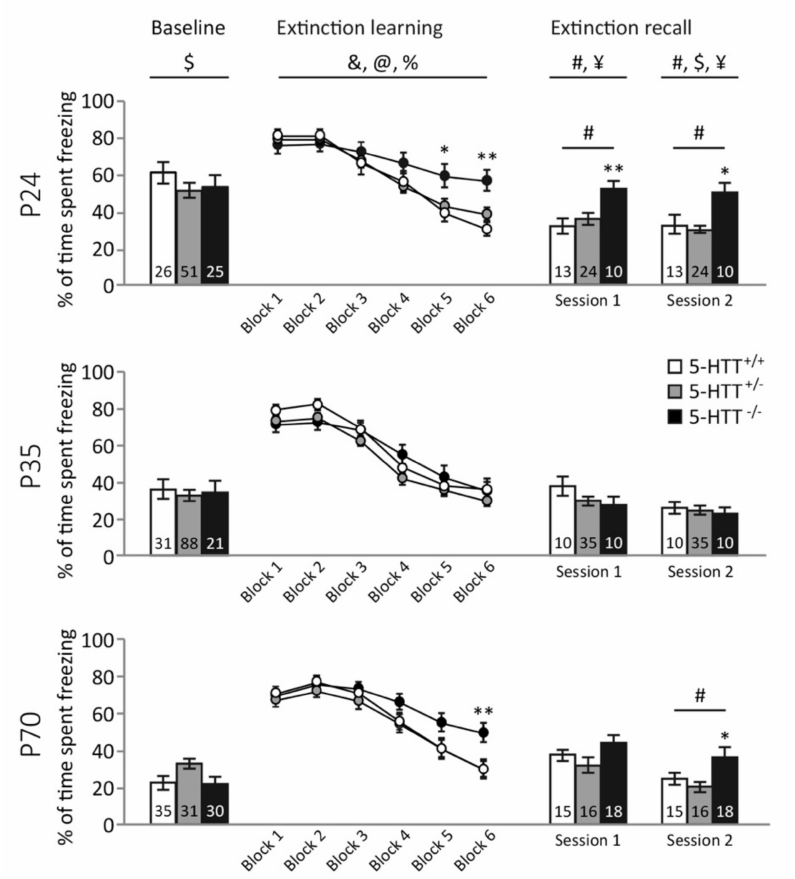
Figure 1. Fear conditioning behavioral data across extinction learning and the two extinction recall sessions. Freezing during the 2-minute stimulus free baseline period preceding extinction learning decreased across age in all genotypes. Fear extinction learning is impaired in preadolescent 5-HTT − / − rats, normalized in this genotype during adolescence, and impaired again in adulthood. Fear extinction recall is impaired in preadolescent 5-HTT − / − rats, normalized in this genotype during adolescence, and impaired again in adulthood. Data are expressed as the mean % of time spent freezing during stimulus presentations ± standard error of the mean. #: a significant effect of genotype ( p < 0.05); $: a significant effect of age ( p < 0.05); ¥: a significant age × genotype interaction ( p < 0.05); *: a significant post hoc difference between 5-HTT − / − vs. 5-HTT +/ − and / or 5-HTT +/+ rats ( p < 0.05); **: a significant post hoc difference between 5-HTT − / − vs. 5-HTT +/ − and / or 5-HTT +/+ rats ( p < 0.05); & a significant effect of extinction block ( p < 0.05); @ a significant age × block interaction ( p < 0.05); % a significant genotype × block interaction ( p <